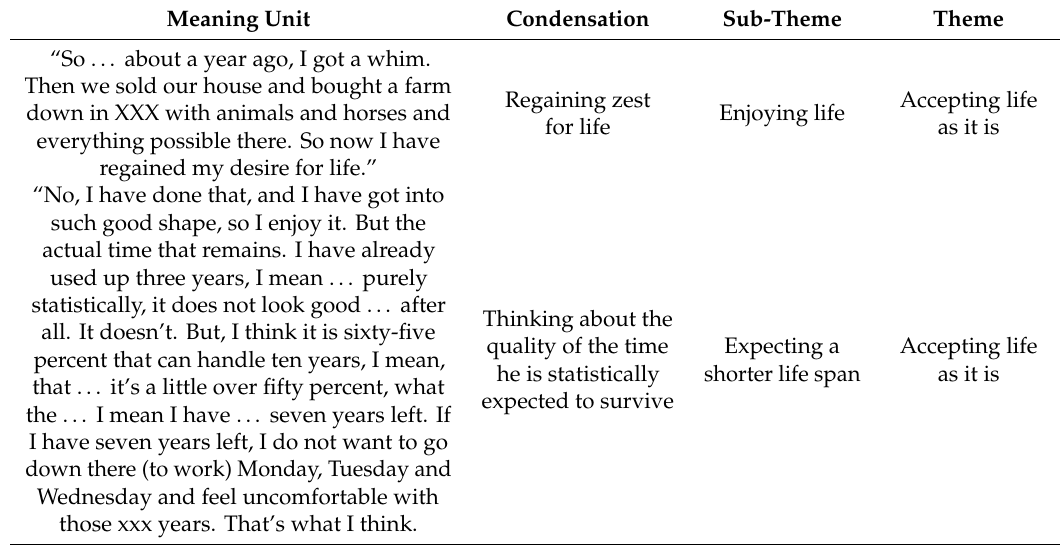
Table 2. Example of the structural